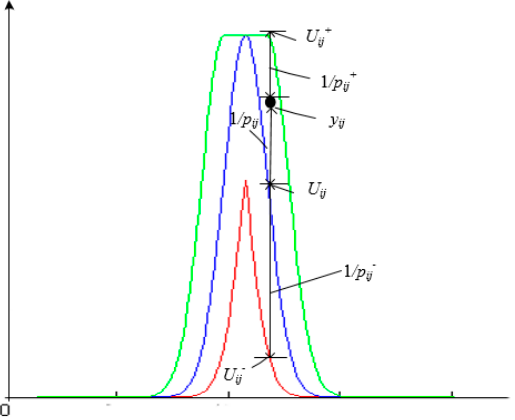
Figure 5. Schematic diagram of weighted average method for classification decision model.